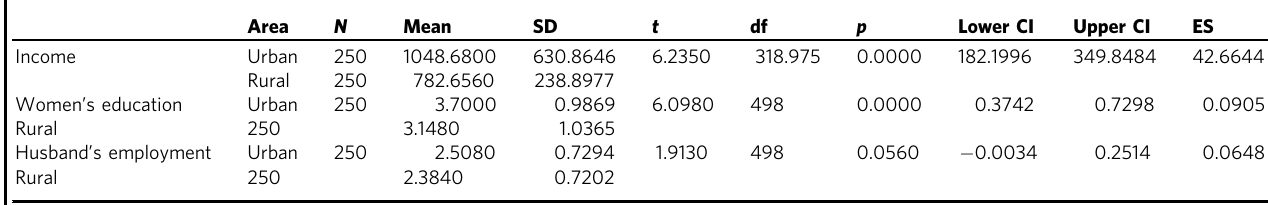
Table 6 Independent sample t -test for area differences in urban and rural women ’ s income and education and husband ’ s employment.